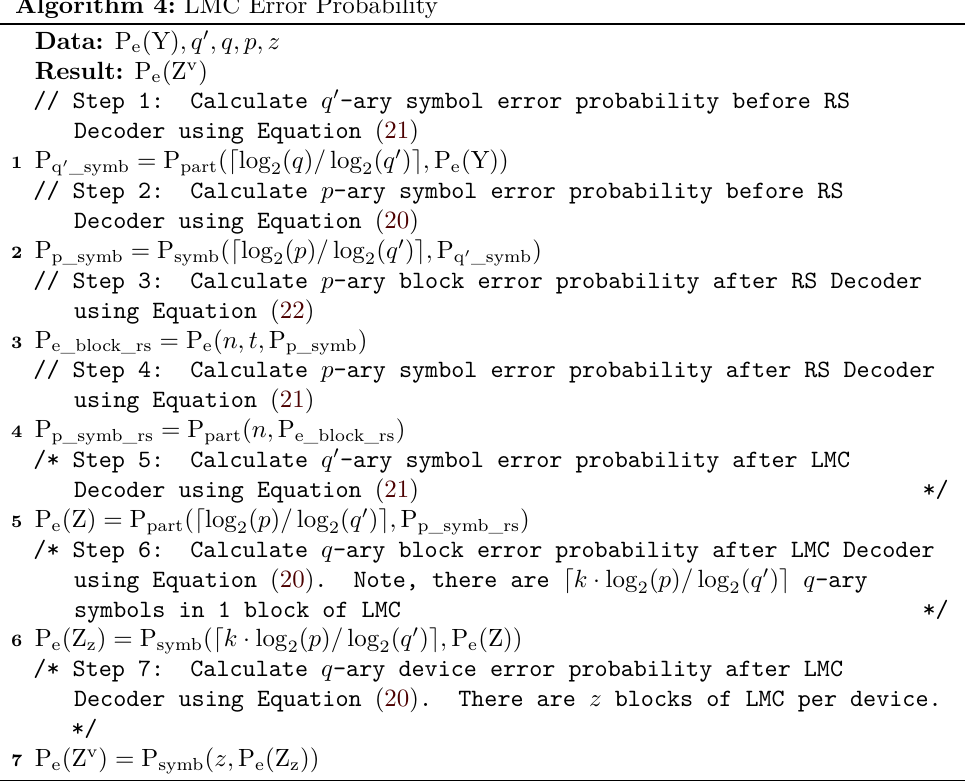
Algorithm 4: LMC Error